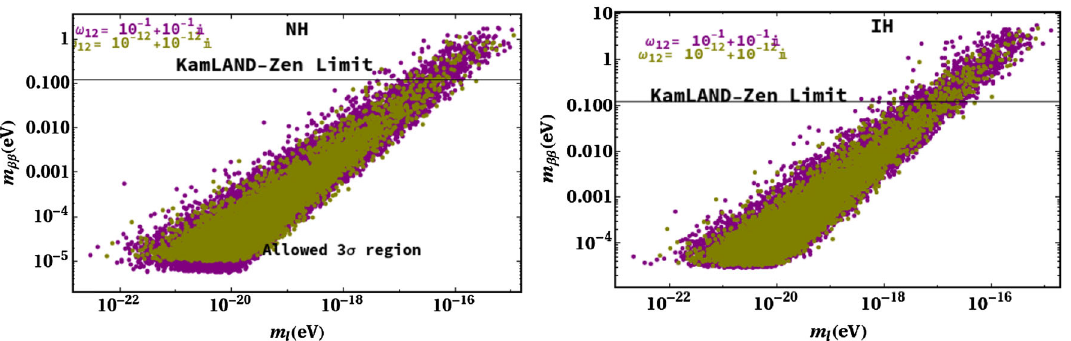
= 10 − 2 + 10 − 2 i . The horizontal black line signify the KamLAND- ω 23